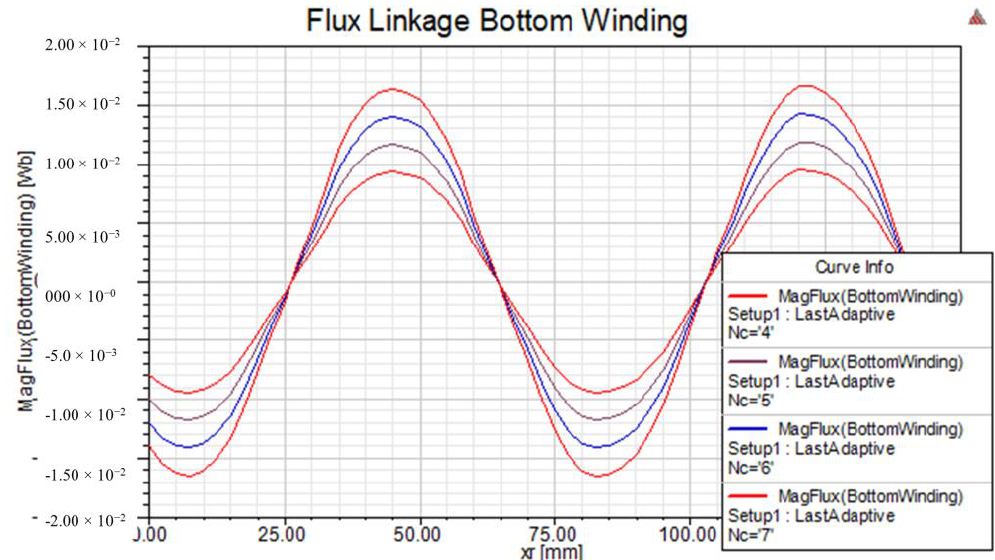
Figure 16. Variation of linkage flux versus variation of the number of poles.